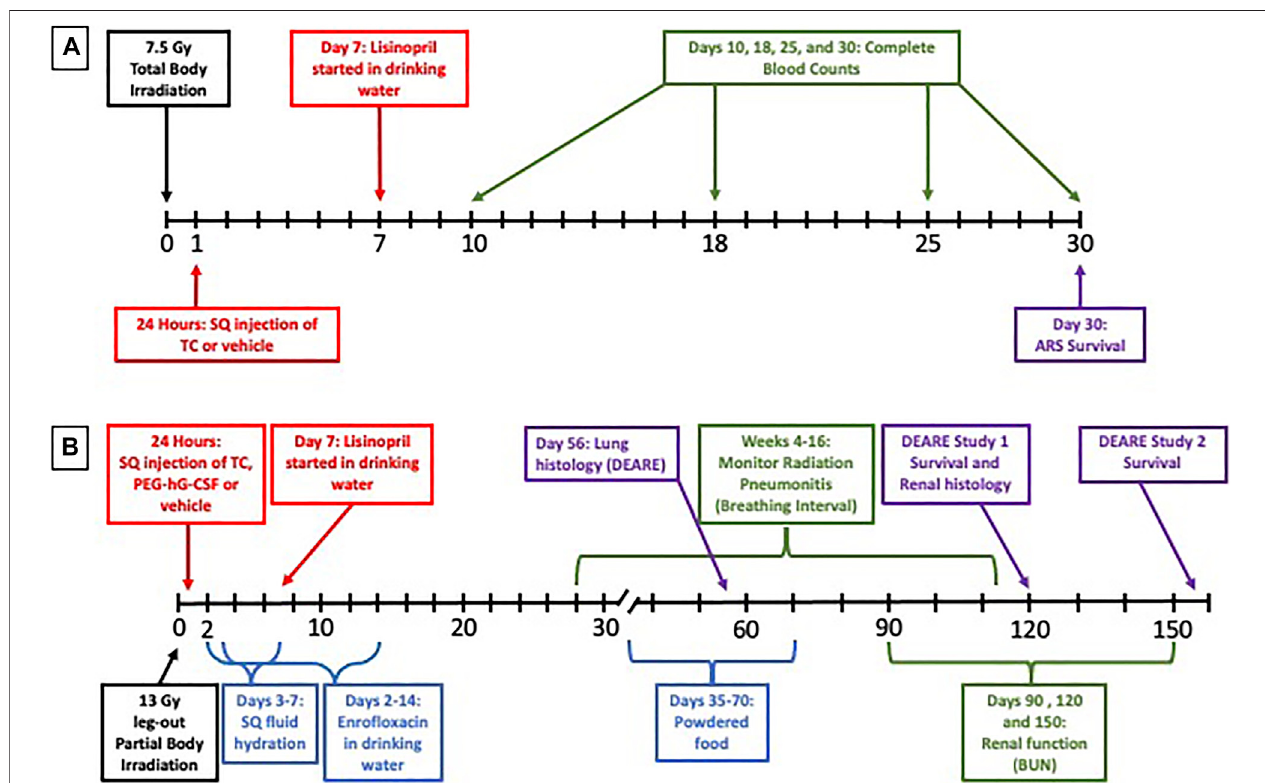
FIGURE 1 | Experimental design. To study the Acute Radiation Syndrome (ARS) (A) , female WAG/RijCmcr rats (11 – 12 weeks of age) were irradiated with 7.5 Gy total body irradiation (TBI). At 24-h post-irradiation, all rats received a subcutaneous (SQ) injection of either the triple combination (TC, consisting of PEG-hG-CSF, PEG mGM-CSFandPEGhIL-11)orvehicleandtheACEinhibitorlisinoprilwasstartedinthedrinkingwater(24 mg m − 2 d − 1 )intwogroupsat7 dayspost-irradiation.Asubset ofeach treatment groupwasbledat days 10,18,25,and30-daysandcompleteblood countswereanalyzed.TheARSexperiment wasterminatedat 30-days.To study the Delayed Effects of Acute Radiation Syndrome (DEARE) (B) , female WAG/RijCmcr rats (11 – 12 weeks of age) were irradiated with 13 Gy leg-out partial body irradiation (leg-out PBI). At 24-h post-irradiation, all rats received a subcutaneous (SQ) injection of either the triple combination (TC, consisting of PEG-hG-CSF, PEG mGM-CSF and PEG hIL-11), PEG-hG-CSF or vehicle and the ACE inhibitor lisinopril was started in the drinking water (24 mg m − 2 d − 1 ) in two groups at 7 days post- irradiation. Supportivecareconsisting ofantibiotics(enro fl oxacin,10 mg kg − 1 d − 1 ,days2 – 14)inthedrinkingwater,SQ fl uid hydration(saline,40 ml kg − 1 d − 1 ,days3 – 7) and supplemental powdered diet (days 35 – 70) were provided to all rats in the DEARE study. Radiation pneumonitis was monitored weekly by recording breathing rates (weeks4 –